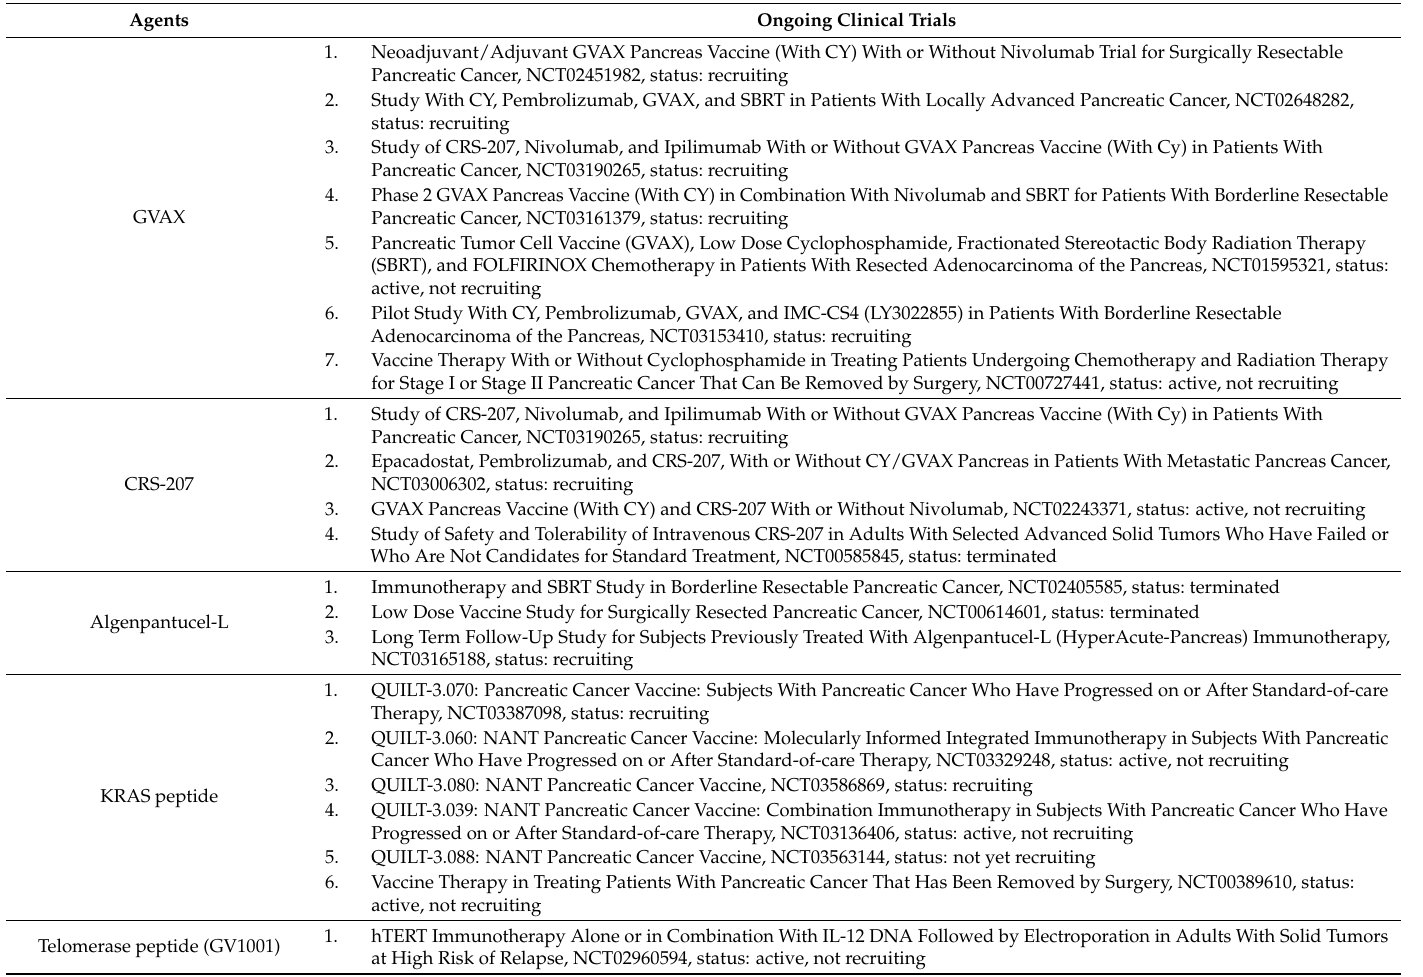
Table 4. Summary of ongoing clinical trials on